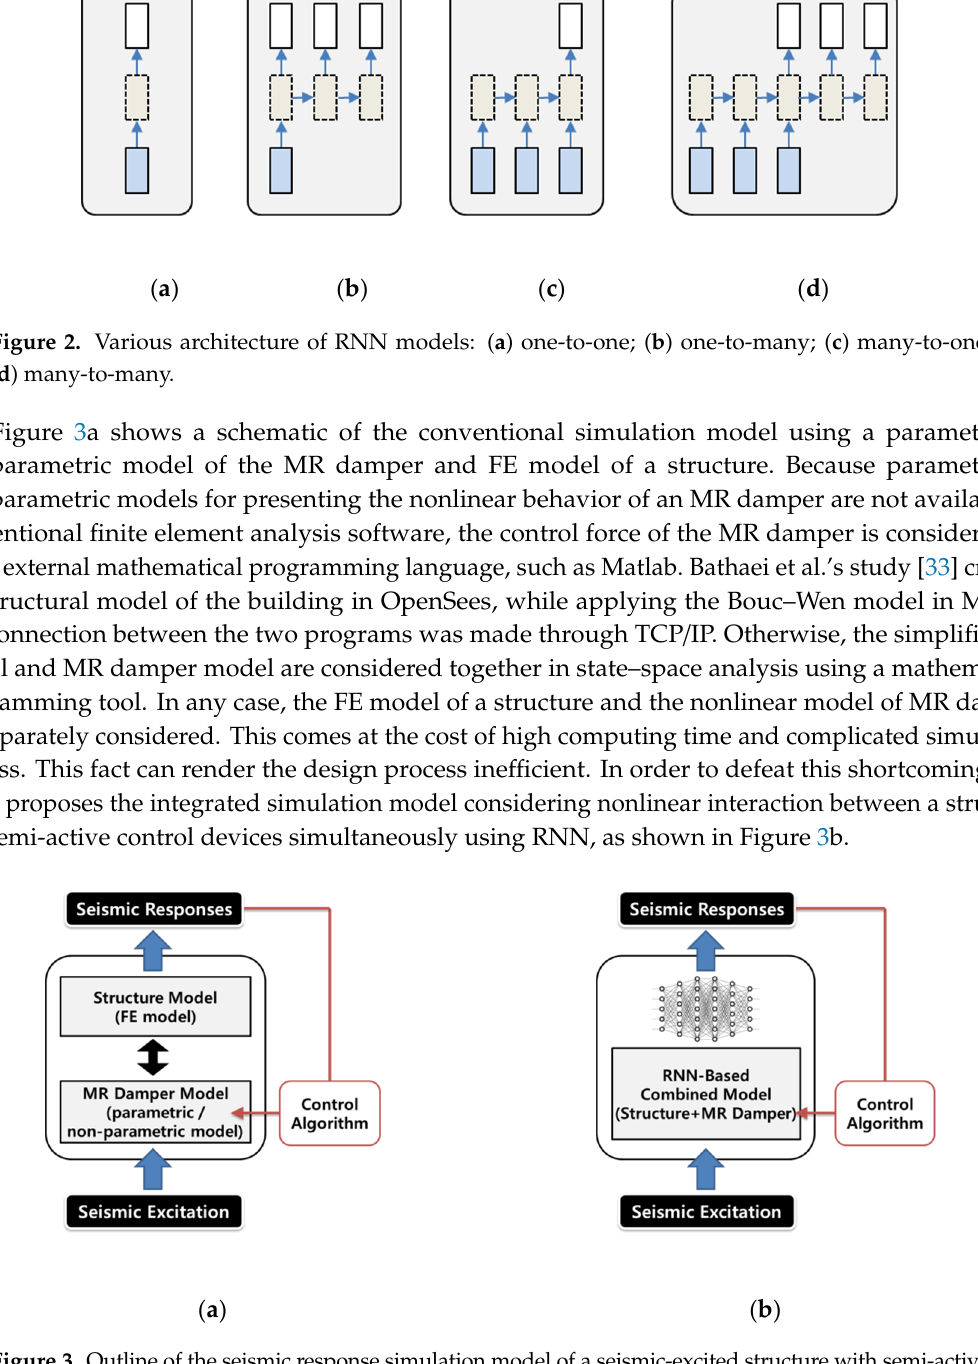
( b ) Figure 4. Analytical models of example structures: ( a ) Model with a semi-active tuned mass damper (Example 1); ( b ) Model with a semi-active mid-story isolation system (Example 2).